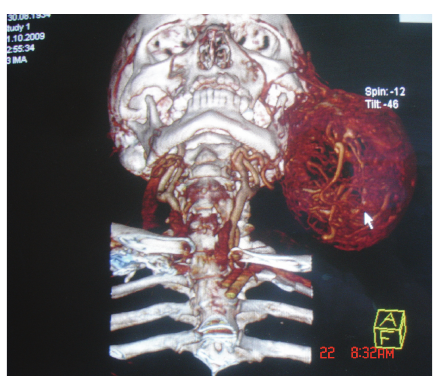
Figure 2: CT angiography displaying the rich vascular network.